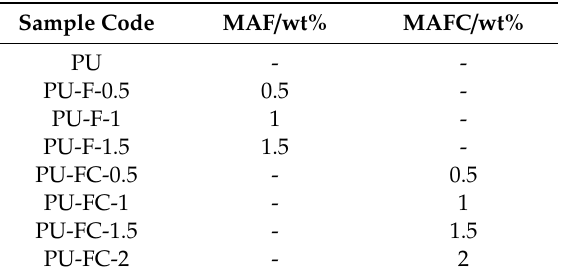
Table 1. Formulations of polyurethane (PU)